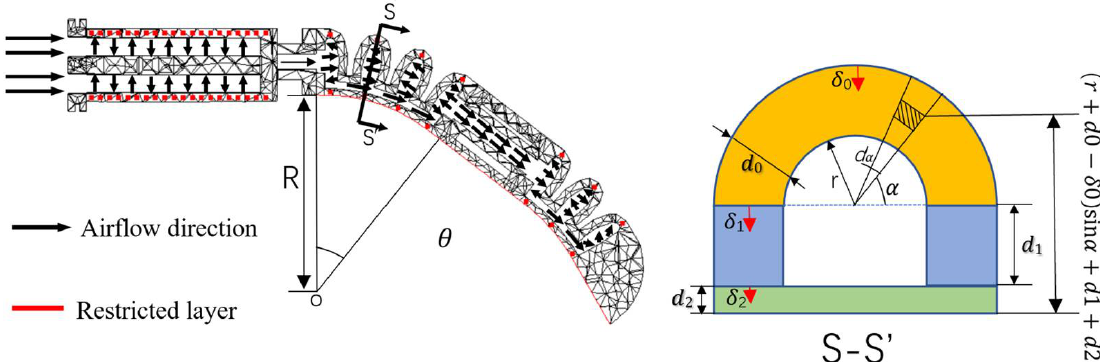
Figure 6. The bending diagram middle finger joint. During the rotation of the interphalangeal joint, the main factors affecting the bending deformation of the driver are the inner surface torque (cid:1839)